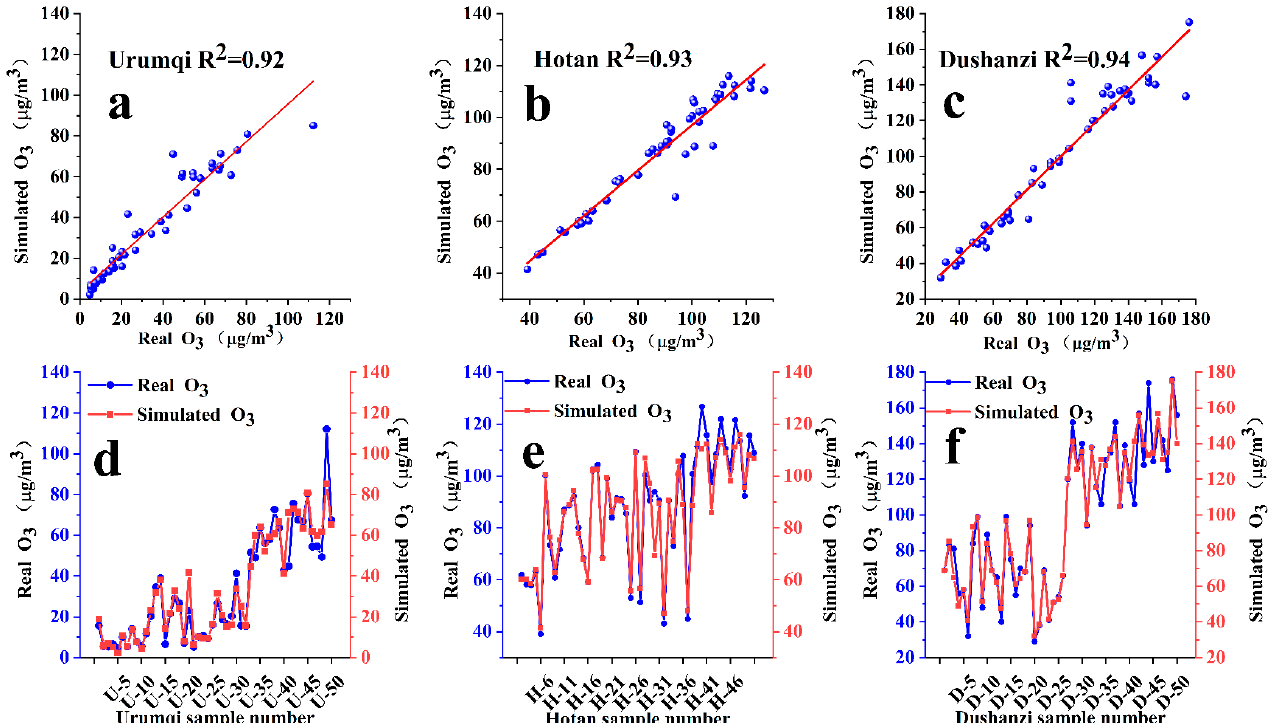
Figure 4. GA-BP artificial neural network model simulation results. ( a ) Results of linear fitting between real and simulated ozone values in Urumqi City. ( b ) Results of linear fitting between real and simulated ozone values in Hotan City. ( c ) Results of linear fitting between real and simulated ozone values in Dushanzi District. ( d ) Comparison of real and simulated ozone values in Urumqi City. ( e ) Comparison of real and simulated ozone values in Hotan City. ( f ) Comparison of real and simulated ozone values in Dushanzi District.